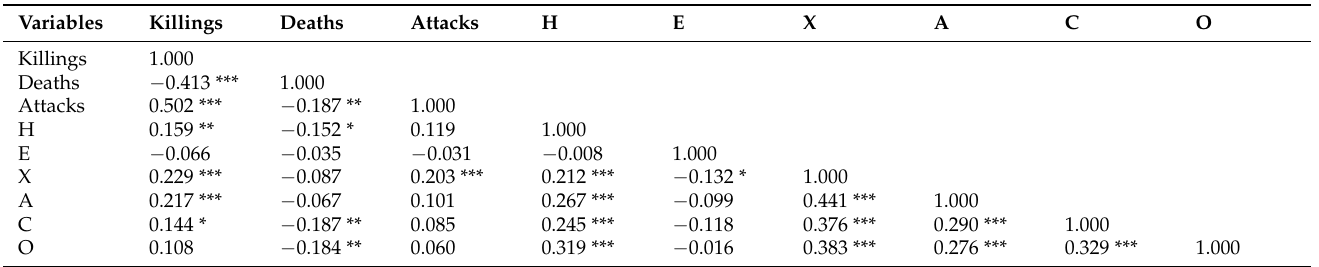
Table 5. Correlations between in-game behaviors and personality